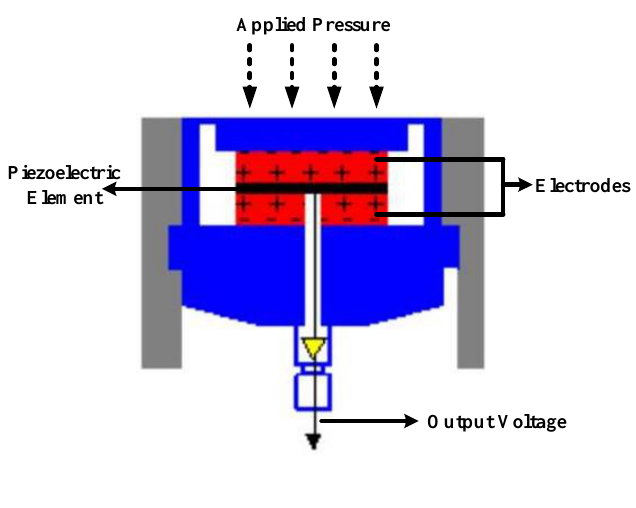
Figure 12. Piezoelectric pressure sensor construction [39].